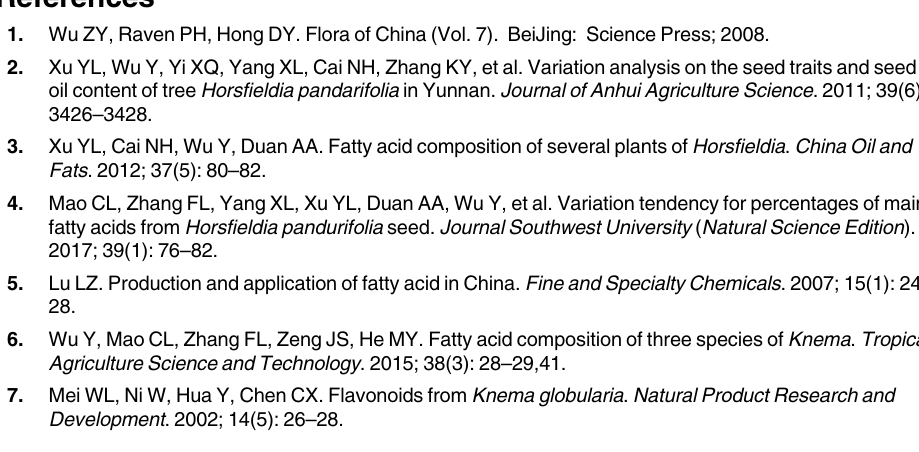
S1 Table. Mononucleotide and dinucleotides SSR site information of ten species of Myris- ticaceae. S2 Table. The synonymous (dS) and dN/dS ratio values of 74 protein coding genes from ten cp genomes of